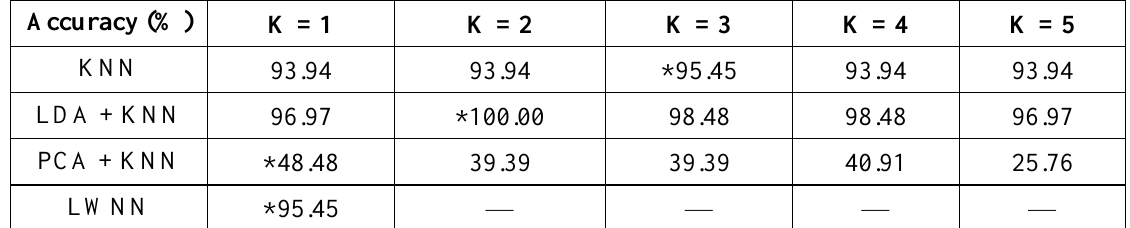
Table 5. Accuracy of the KNN-based